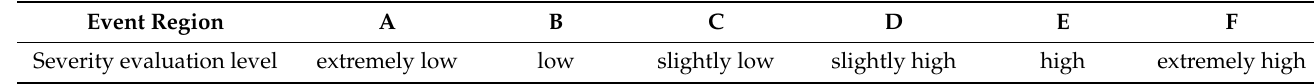
Figure 4. Graded regions of the severity of voltage sag events. Table 1. Grading of the severity of voltage sag events.